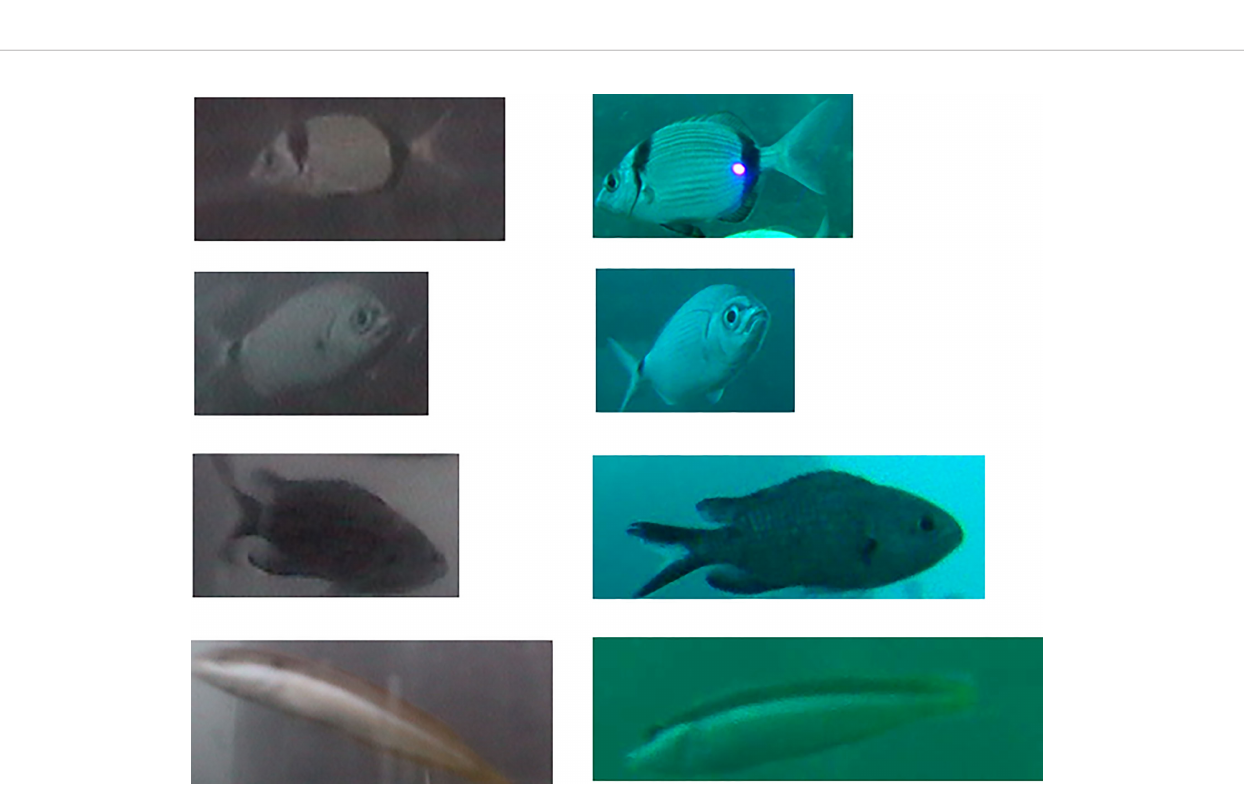
FIGURE 6 | Four examples of fi sh images before (left) and after (right) the substitution of the OBSEA camera with the new one with improved colour